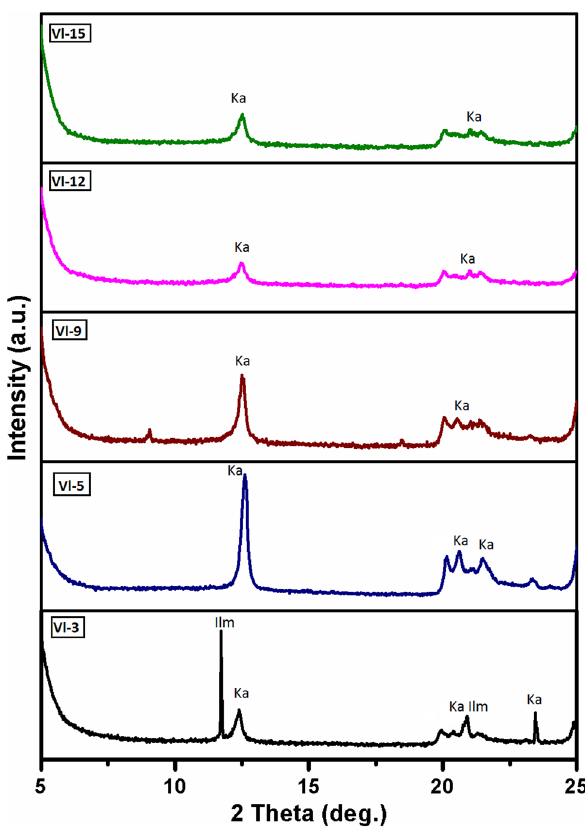
Fig. 4 XRD data obtained on clay fraction of the samples ( Ka Kao- linite, Ilm